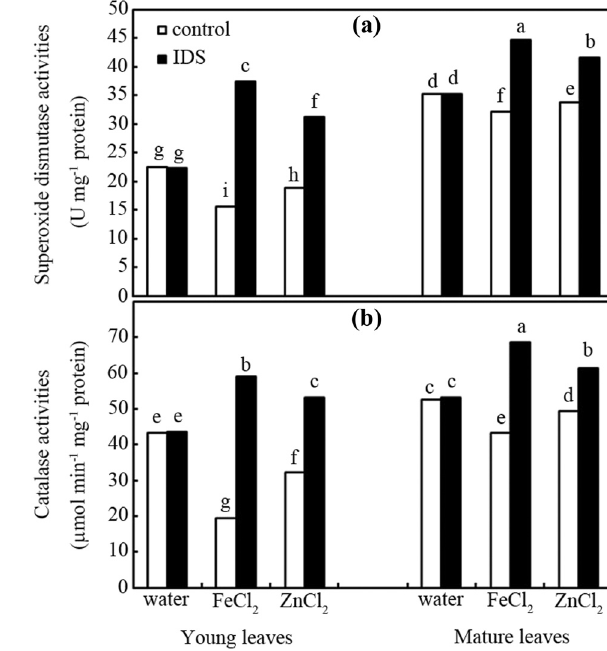
Figure 2: Antioxidant enzyme activities. E ff ects of foliar spraying with a mineral element fertilizer in the ionic ( FeCl 2 and ZnCl 2 ) and chelate ( Fe - IDS and Zn - IDS ) forms on ( a ) SOD and ( b ) CAT activities were monitored in the young and mature leaves of jujube after treat - ment for 7 days. Mean values assigned with the same letter are not signi fi cantly di ff erent ( n = 3; p < 0.05 ) . IDS, iminodisuccinic